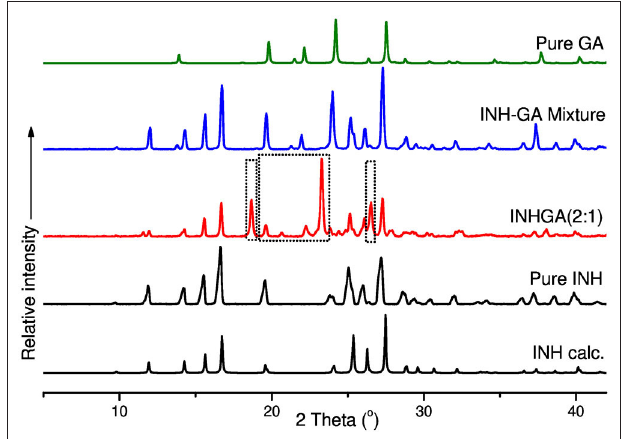
FIGURE 7 | PXRD patterns of pure and calculated isoniazid, pentanedioic acid, INHGA (2:1) co-crystal, and INH-GA physical mixture.